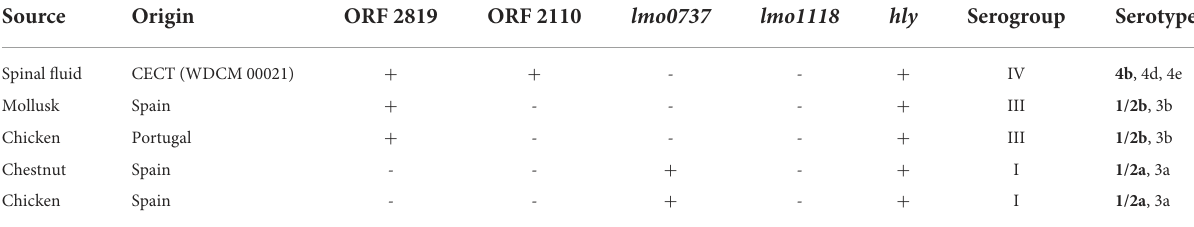
TABLE 1 L. monocytogenes strain